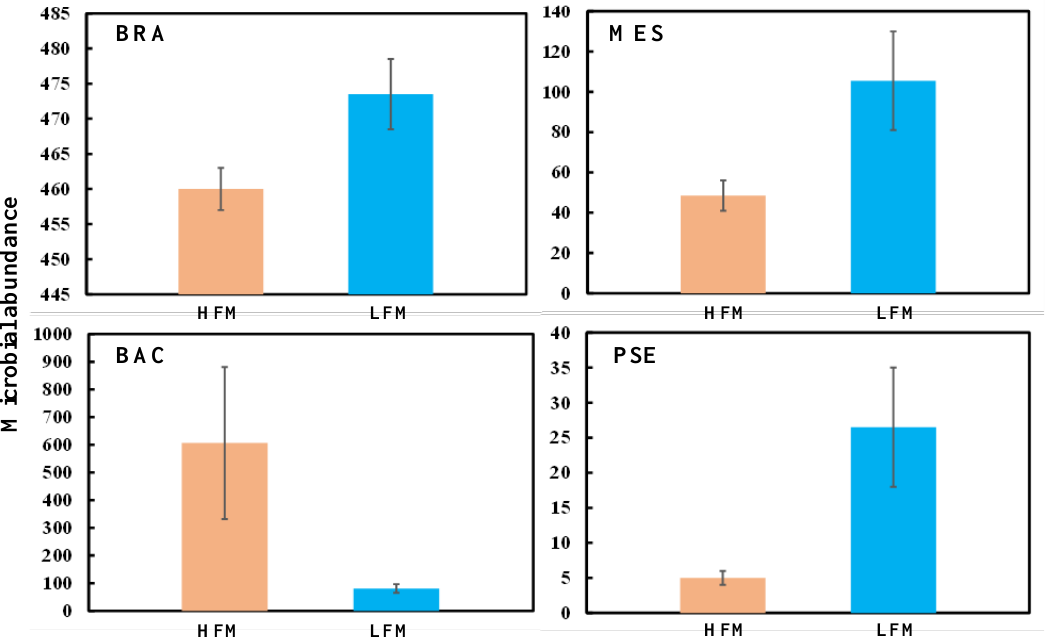
Figure 5. The average abundances of Bradyrhizobium ( BRA ), Mesorhizobium ( MES ), Bacillus ( BAC ), and Pseudomonas ( PSE ) species in different freezing – thawing cycle modes (FTCMs). The vertical line indicates the error limit, HFM is the high-frequency mode, and LFM is the low-frequency mode.